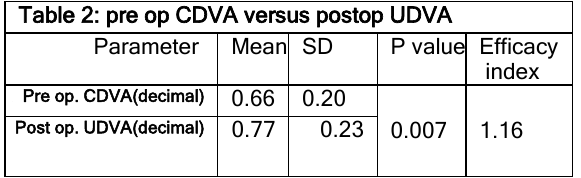
Expected Spherical equivalent(D)